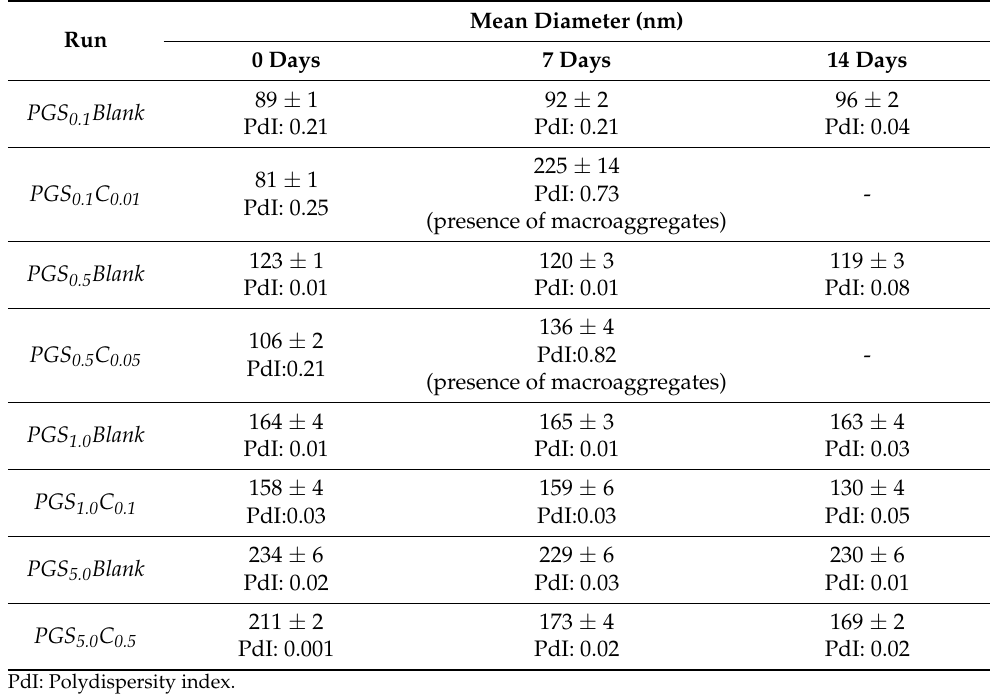
Table 1. Effect of polymer concentration on PGS-NPs particle diameter at t = 0, after 7 days and after 14 days from sample preparation.